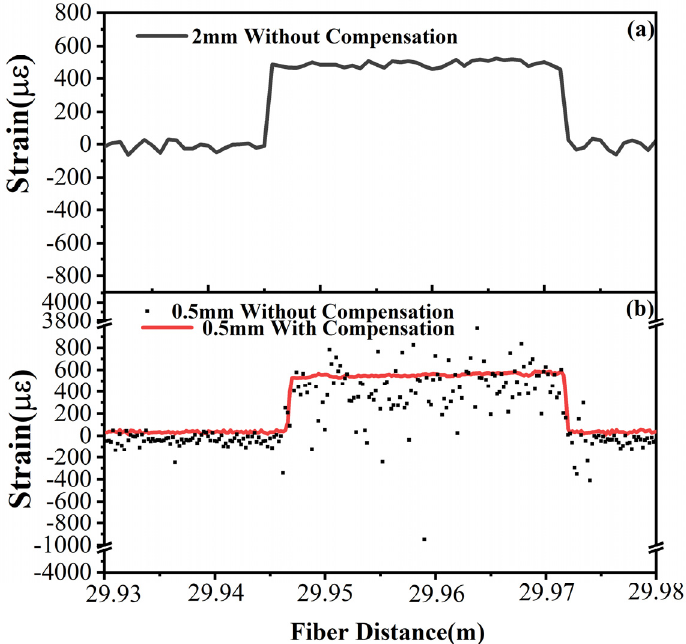
Figure 8. Strain distribution at the fiber end before and after position deviation correction: ( a ) 2 mm spatial resolution; ( b ) 0.5 mm spatial resolution.